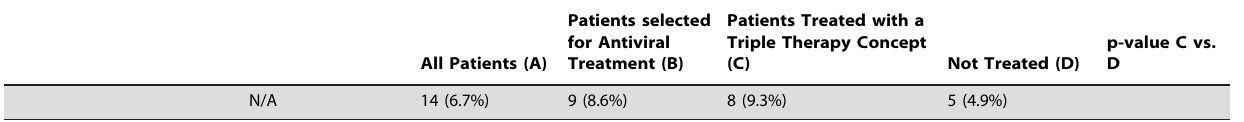
Patients selected for